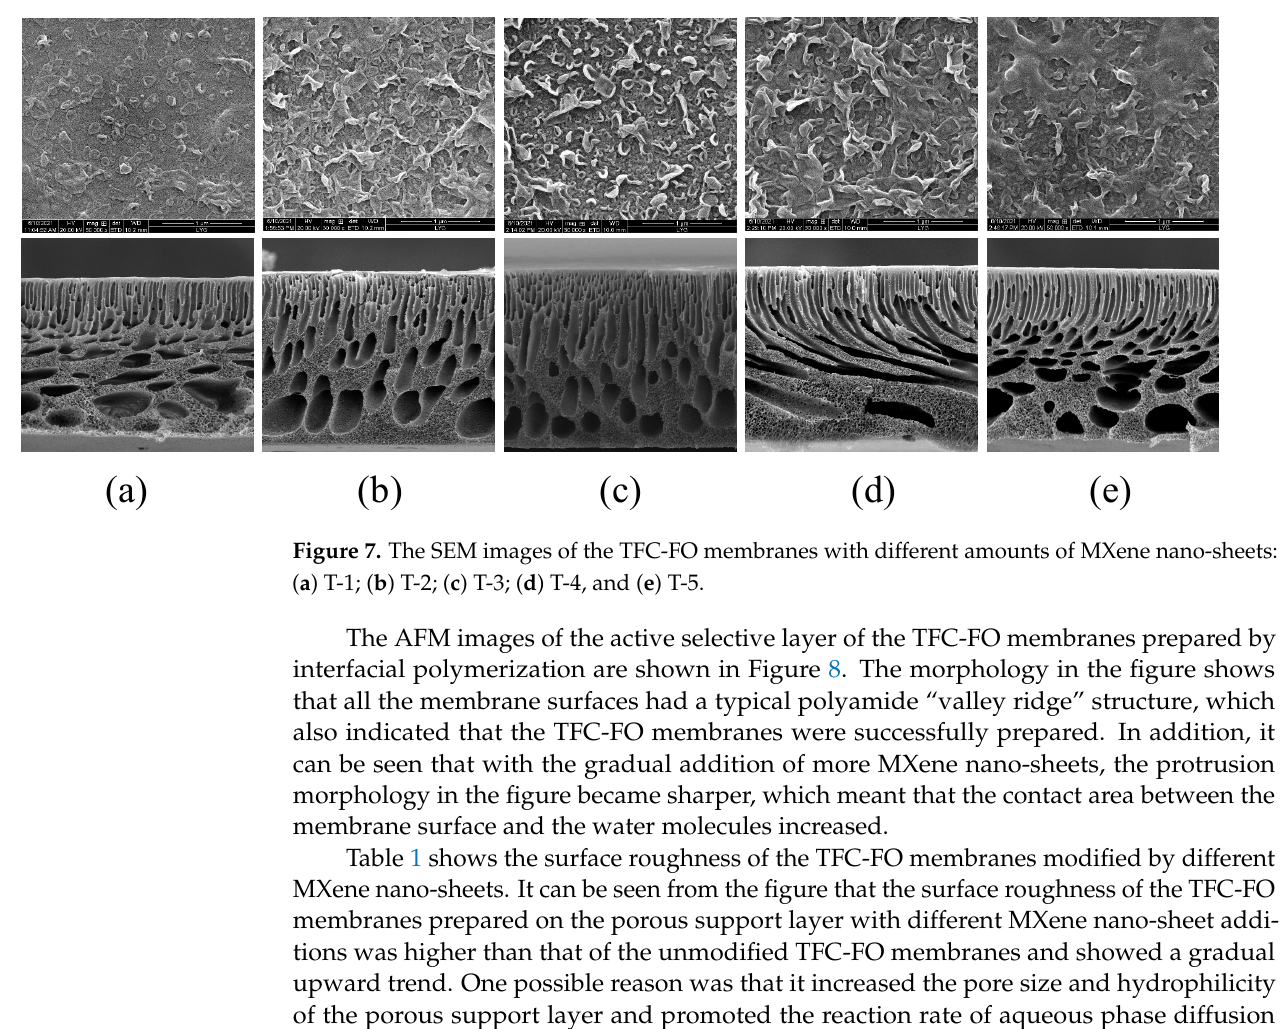
Figure 6. The EDX diagram of the TFC-FO membranes with different amounts of MXene nano- sheets: ( a ) T-2; ( b ) T-3; ( c ) T-4, and ( d ) T-5.